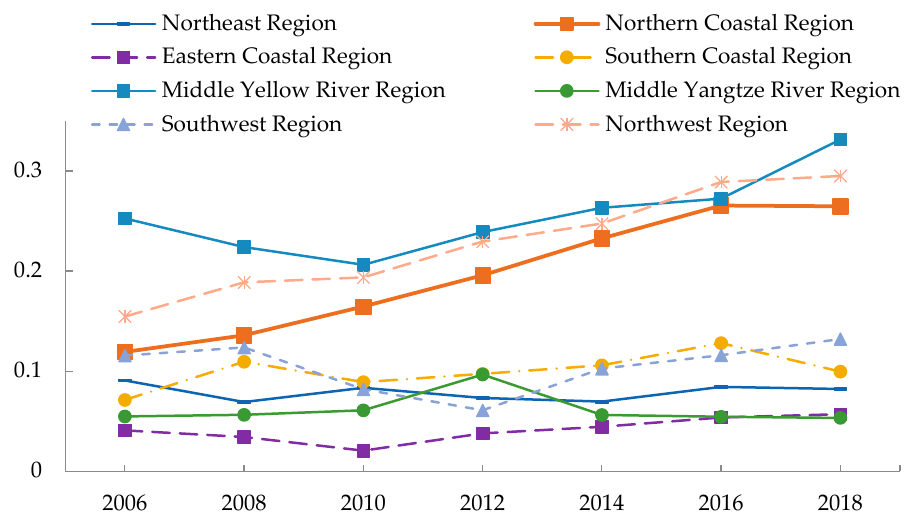
Figure 5. Trends of intra-regional differences of EWP in the eight economic regions. Table 7. Spatial polarization trend of EWP in China: based on the Wolfson index.